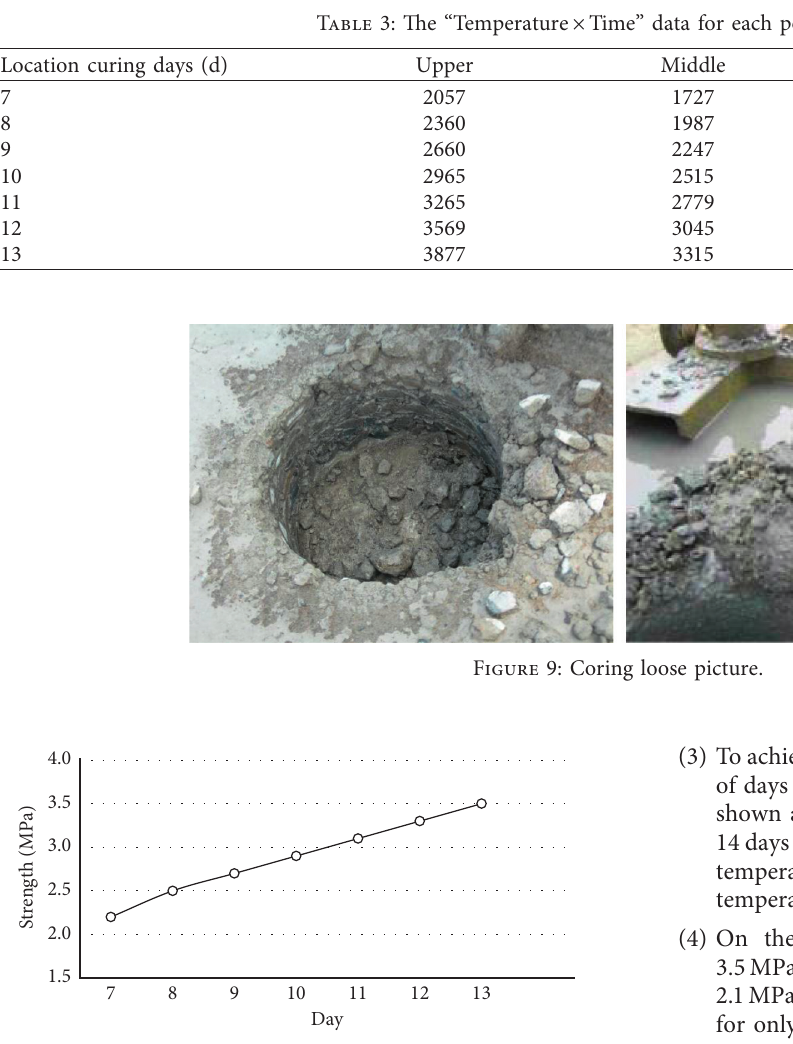
Figure 10: Strength gain curve under outdoor natural temperature curing.